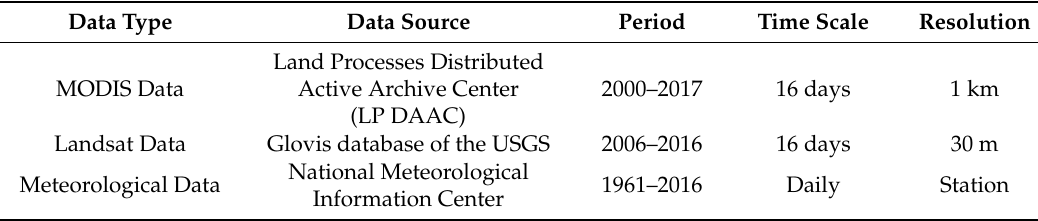
Table 1. Input data. MODIS: moderate-resolution imaging spectroradiometer; USGS: United States geological